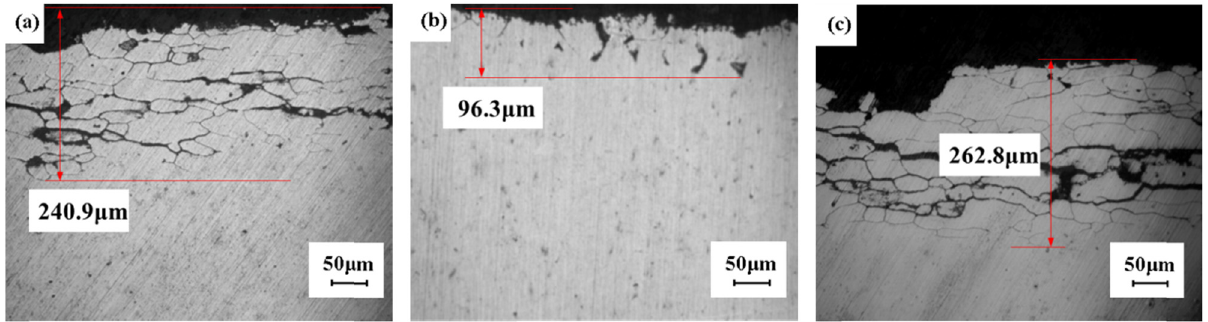
Figure 13: Intergranular corrosion morphology of the joint after PWHT: ( a ) HT1 joint, ( b ) HT2 joint, and ( c ) HT3